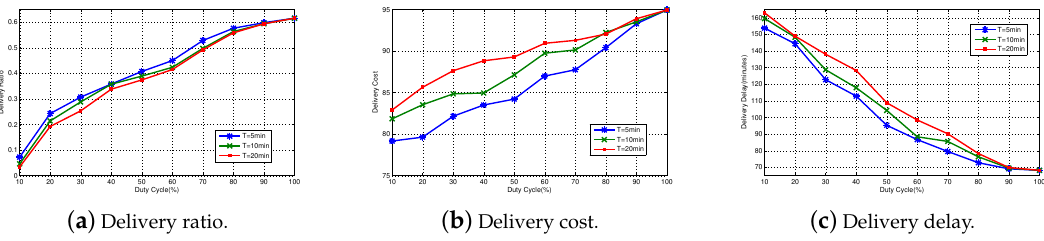
Figure 8. The comparison of delivery ratio ( a ), delivery cost ( b ) and delivery delay ( c ) based on the epidemic routing protocol in Infocom6 trace with the different